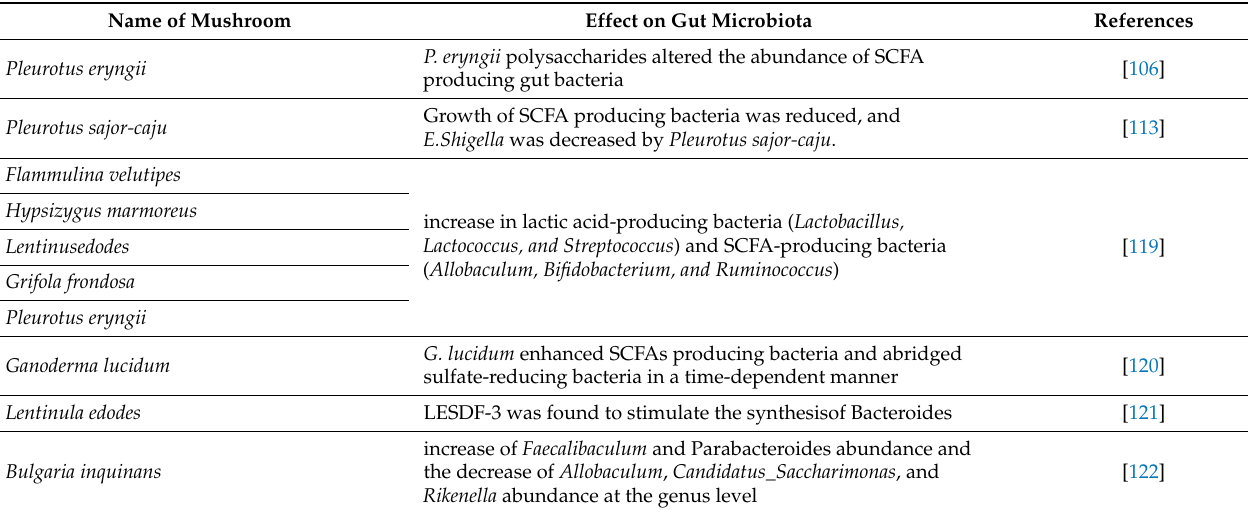
Table 2. Effect of various mushrooms on gut